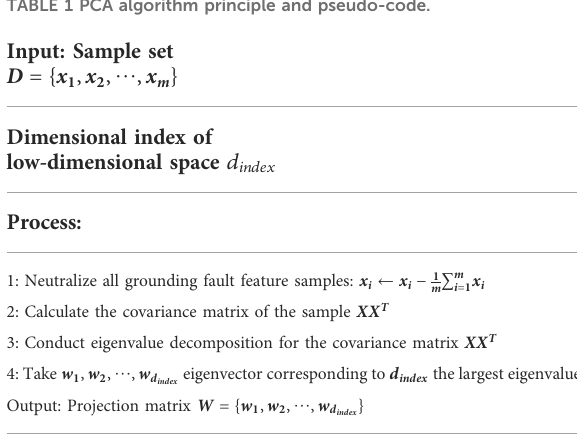
TABLE 1 PCA algorithm principle and